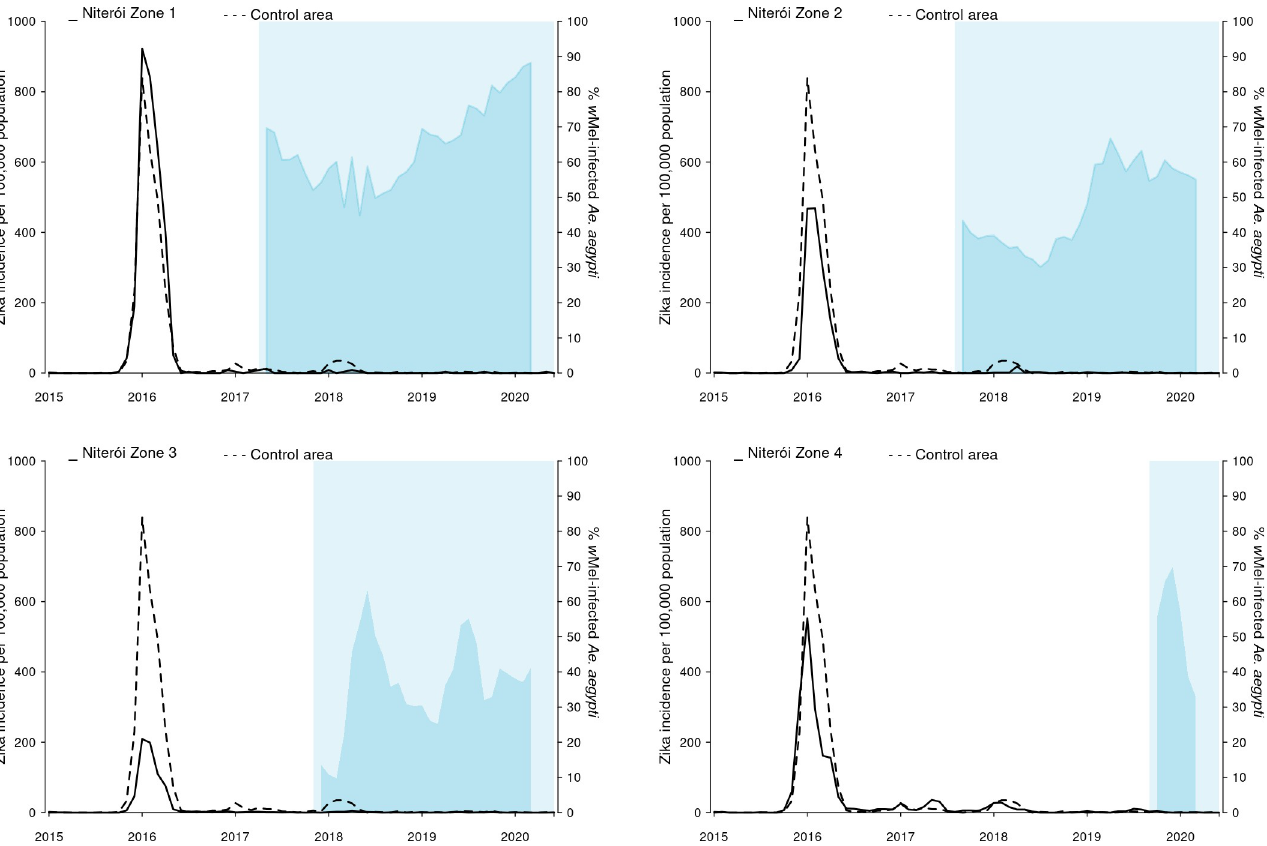
Fig 6. Zika incidence and w Mel infection prevalence in local Aedes aegypti mosquito populations, by release zone. Lines show the monthly incidence of Zika case notifications per 100,000 population (left-hand Y axis) in Nitero´i release zones 1–4 (solid line in each panel) compared with the untreated control zone (dashed line), January 2015—June 2020. Light blue shading indicates the beginning of the epidemiological monitoring period in each zone, one month after initial releases were completed in each respective zone. Darker blue shading indicates the aggregate w Mel infection prevalence (right-hand Y axis) in each zone in each calendar month from the start of the epidemiological monitoring period until March 2020 (no w Mel monitoring April—June